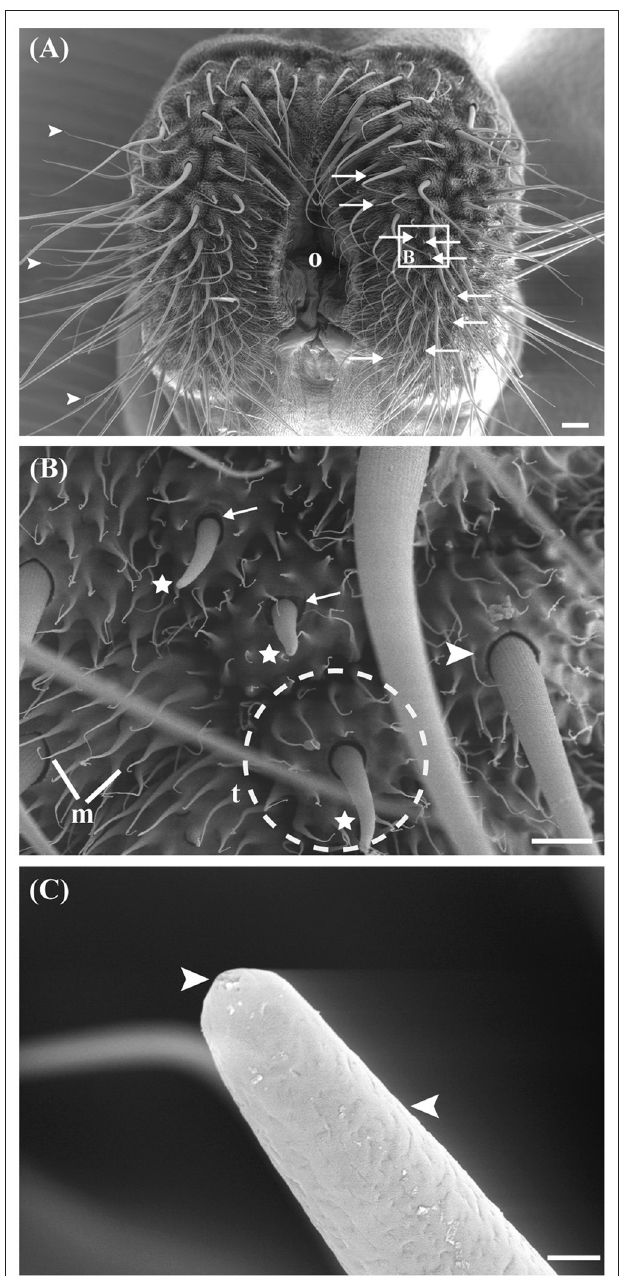
FIGURE 2 | Scanning electron micrographs (SEM) of the ovipositor of M. sexta and its associated sensilla. (A) Ventral overview of the extended terminal segment of the M. sexta ovipositor, which contains two anal papillae surrounding the ovipore (o). Most abundant are filiform sensilla (arrowheads), which vary in length. Nine putative chemosensory sensilla occur on each papilla (arrows). White box and letter in this picture presents the place where the following picture originates. (B) The non-porous, filiform sensilla have raised sockets (arrowheads). Asterisks indicate putative chemosensory sensilla with sockets showing flexible areas (arrows). The papillae are covered with short-pointed microtrichia (m) and tubercles (t; indicated by dashed circle). (C) Detailed view of one putative olfactory sensillum. The shaft is pierced by numerous small pores and one large terminal pore (arrowheads). Scale bars: (A) 100 µ m; (B) 20 µ m; (C) 1 µ